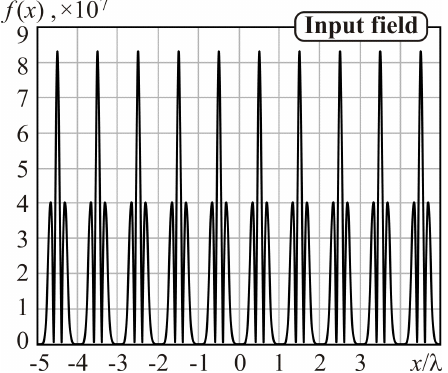
Figure 1. Superoscillating signal of Equation